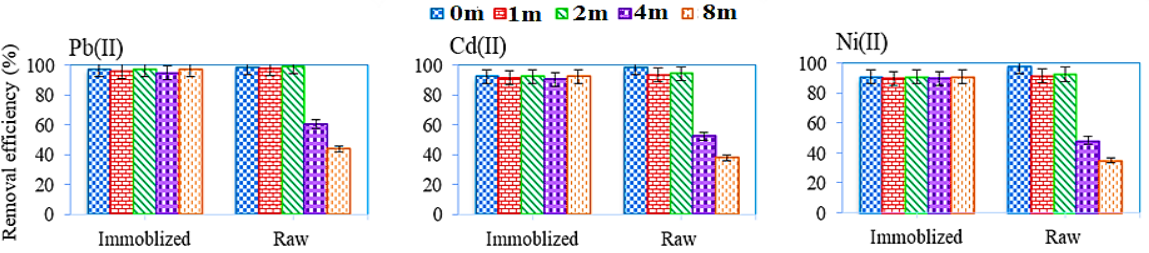
Figure 11. Removal efficiency (%) of Cd(II), Pb(II), and Ni(II) ions by different storage times for immobilized and raw S. cerevisiae yeast. Table 7. Water quality parameters of raw wastewater, and treated water after the application of S.